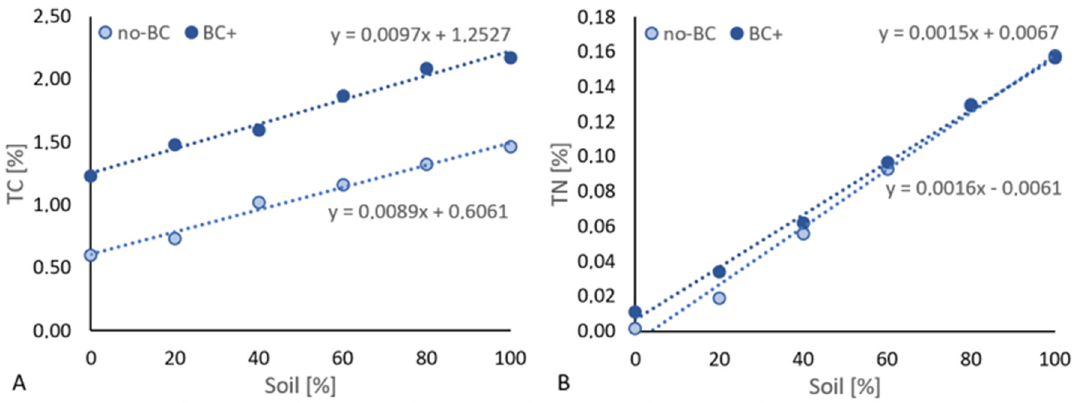
Figure A2. The relationship of total carbon ( A ) and total nitrogen ( B ) and the sand:soil ratio (expressed as a percentage of soil). Data series are described by regression curves and equations. Table A2. Results of two-way analysis of variance ANOVA.